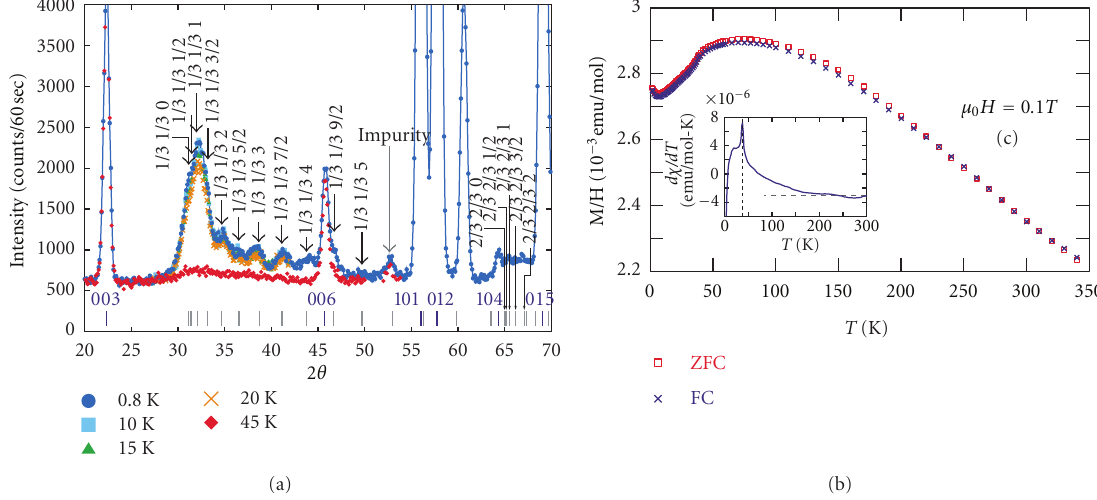
Figure 11: (a) Powder neutron di ff raction patterns of PdCrO 2 collected at various temperatures with neutrons of wavelength λ = 2 . 3475 ˚ A . The broadness of the magnetic peaks indicates that the correlations are short ranged. Note the observation of (1 / 3 1 / 2 1 / 2) Bragg peaks. (b) Temperature dependence of the field-cooled and zero-field-cooled magnetic susceptibility, χ , measured in a field of 0.1 T. The inset shows a clear anomaly in the derivative dχ/dT at T N = 40K. Both figures are taken from [15].